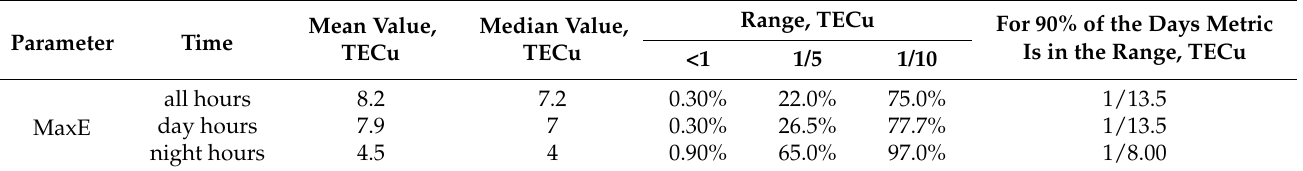
Table 8. Mean and median values and the percentage in a certain range for the MAE and RMSE scores for the MaxE(L31, mean.lag1.2)